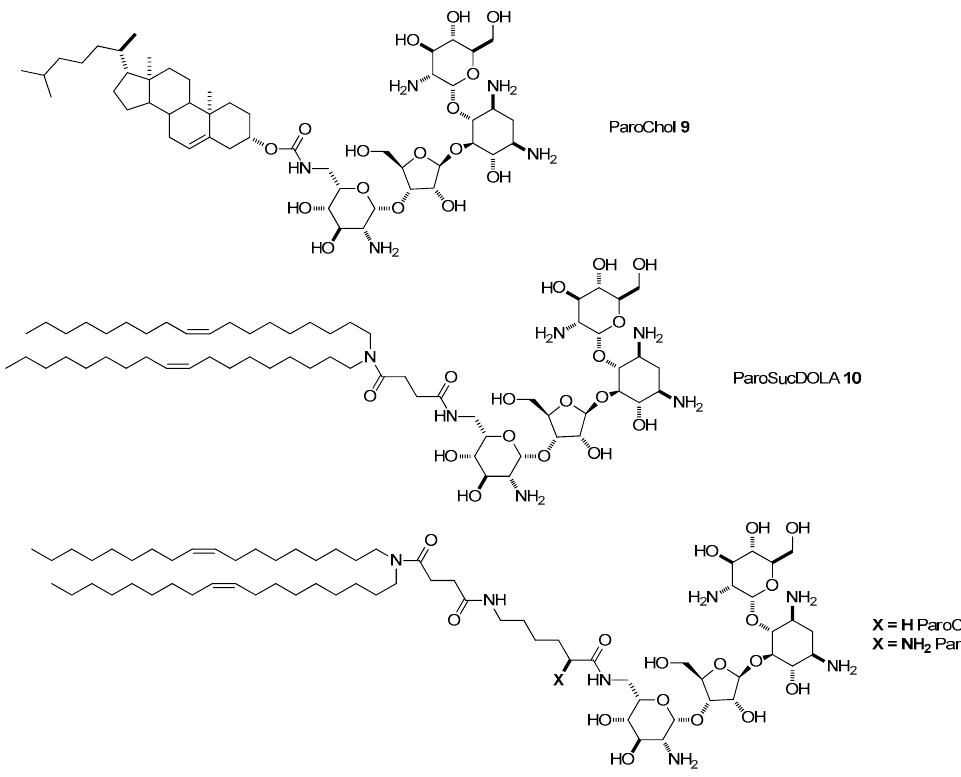
Figure 5. Structures of paromomycin-based lipids 9 – 12 .